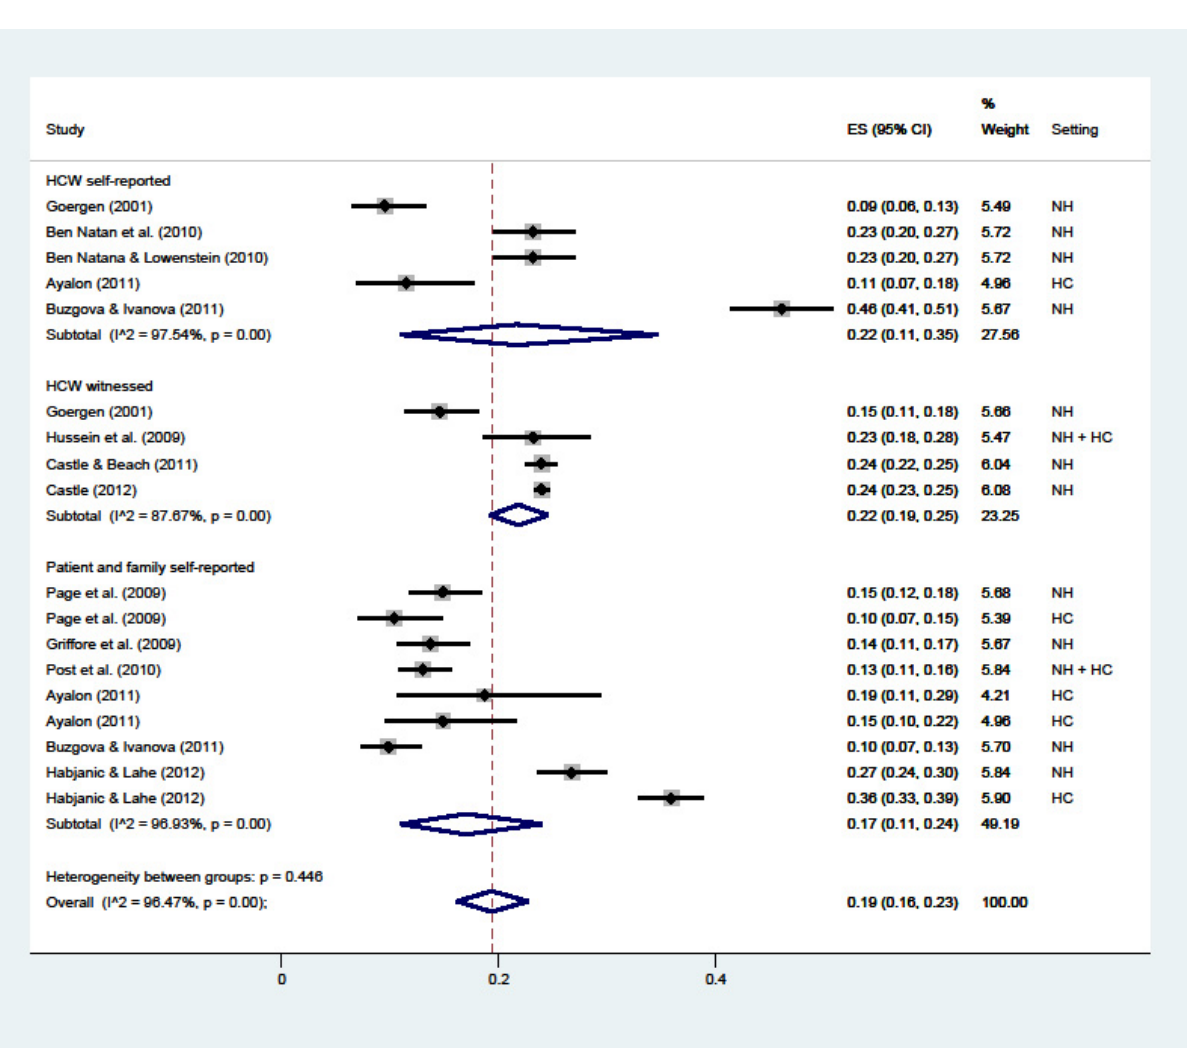
Figure 5. Forest plot of the prevalence of psychological abuse in LTC. Subgroup meta-analyses by (Healthcare workers (HCW) self-reported, HCW witnessed, or patient and family self-reported). NH: nursing home; HC: home care. Sexual violence (Figure 6) had a 2% overall prevalence (C.I. 1–3; I 2 = 95%), with a 1% prevalence from HCWs’ self-reported (C.I. 0–4; I 2 = 93%), a 2% witnessed by HCWs (C.I. 1–4; I 2 = 97%), and a 2% reported by patients or their families (C.I. 0–5; I 2 =